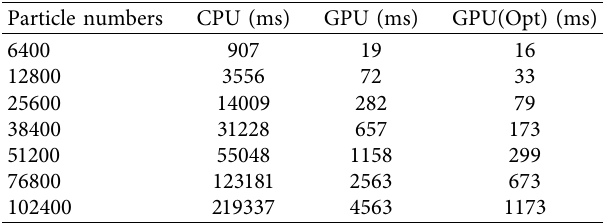
Table 2: CPU algorithm and GPU algorithm running time for pressure extraction.